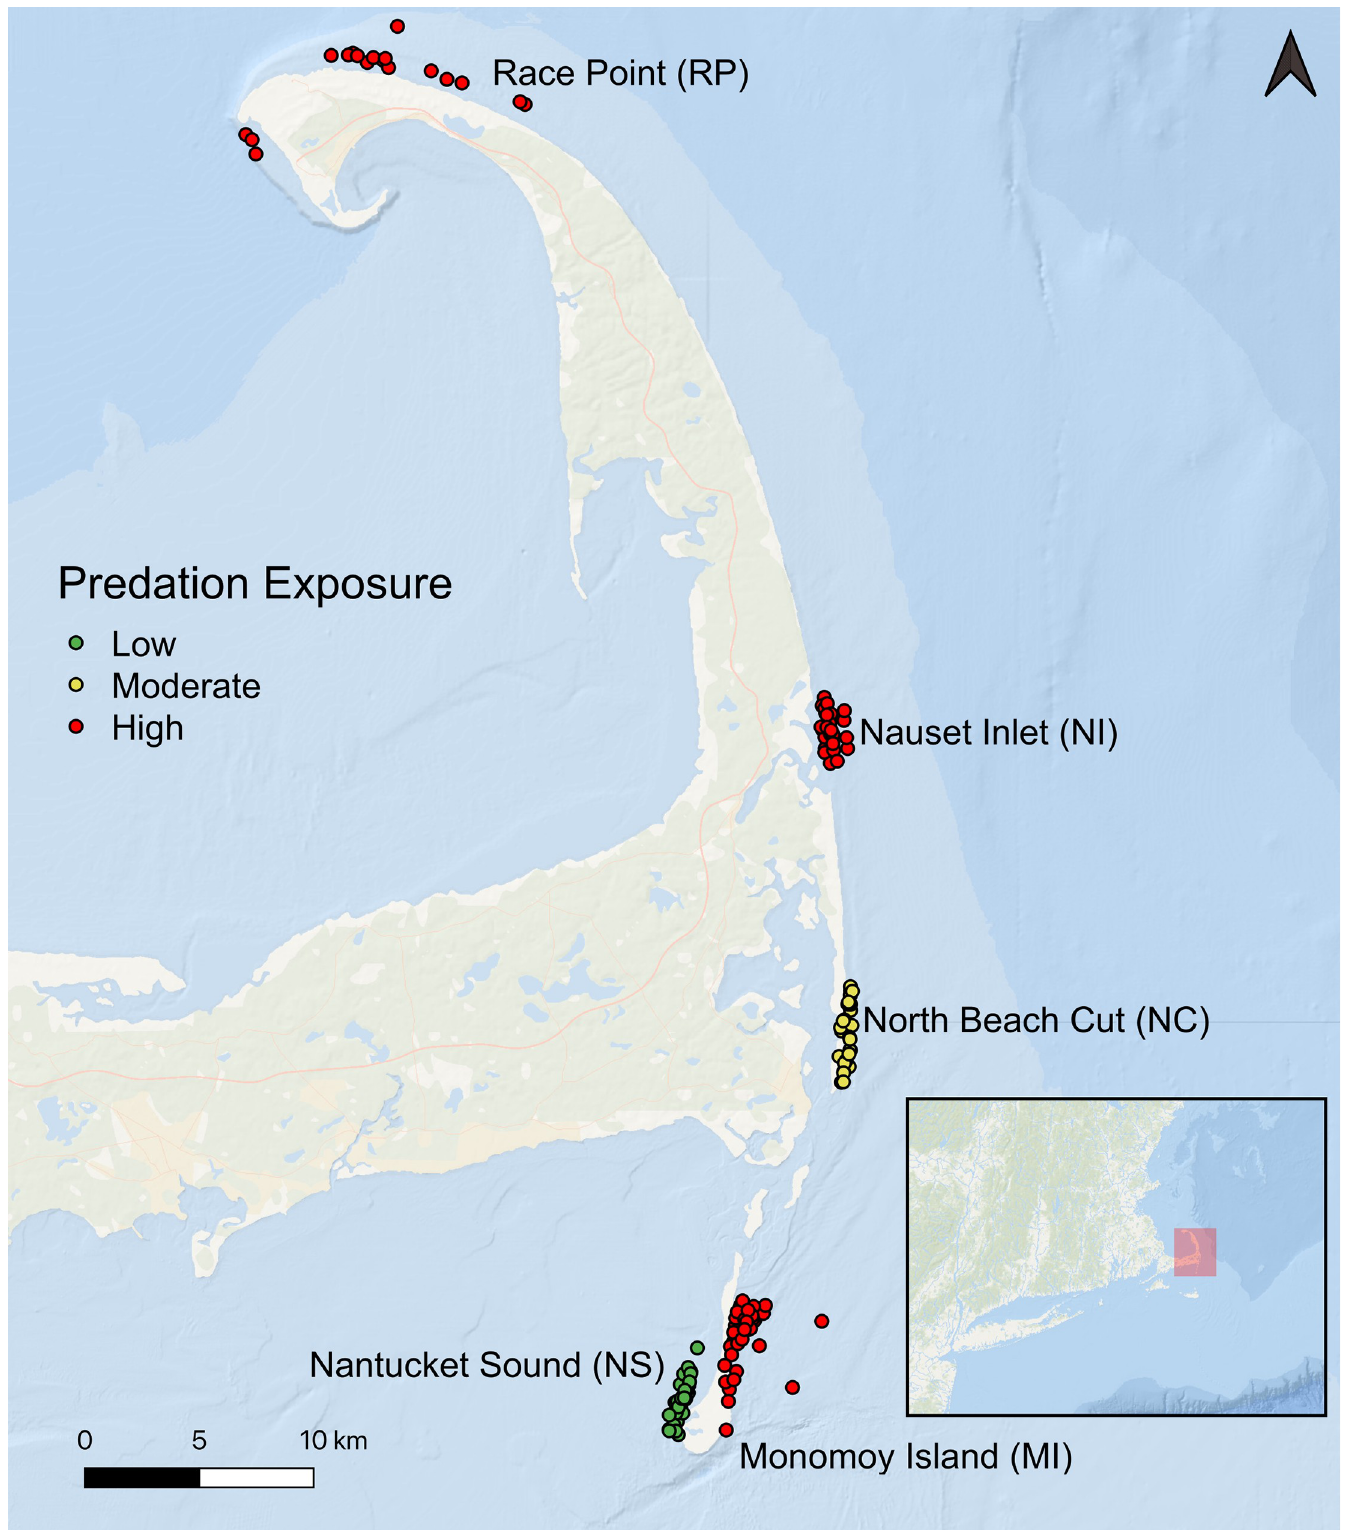
Fig 1. Map of study sites and depiction of BRUV deployments. Map of BRUV deployments off the outer and lower coasts of Cape Cod, Massachusetts, USA. Exposure levels at each site are indicated by the color of the markers.